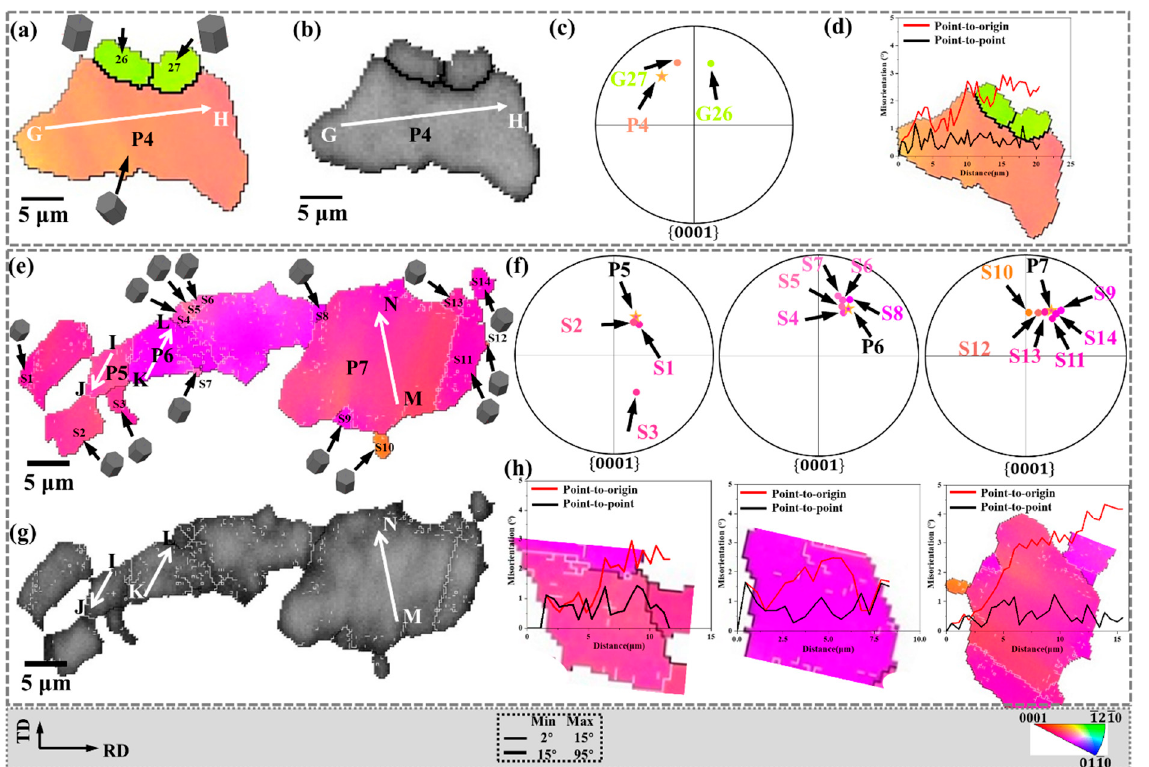
Figure 6. DDRX behavior of the yellow circle region in Figure 4: ( a , e ) the IPF, ( b , f ) {0001} pole figure, and ( c , g ) band contrast and ( d , h ) point-to-origin and point-to-point misorientations map along the black line GH, IJ, KL, and MN. The five-pointed star is the position of the parent grain on the {0001} pole figure.